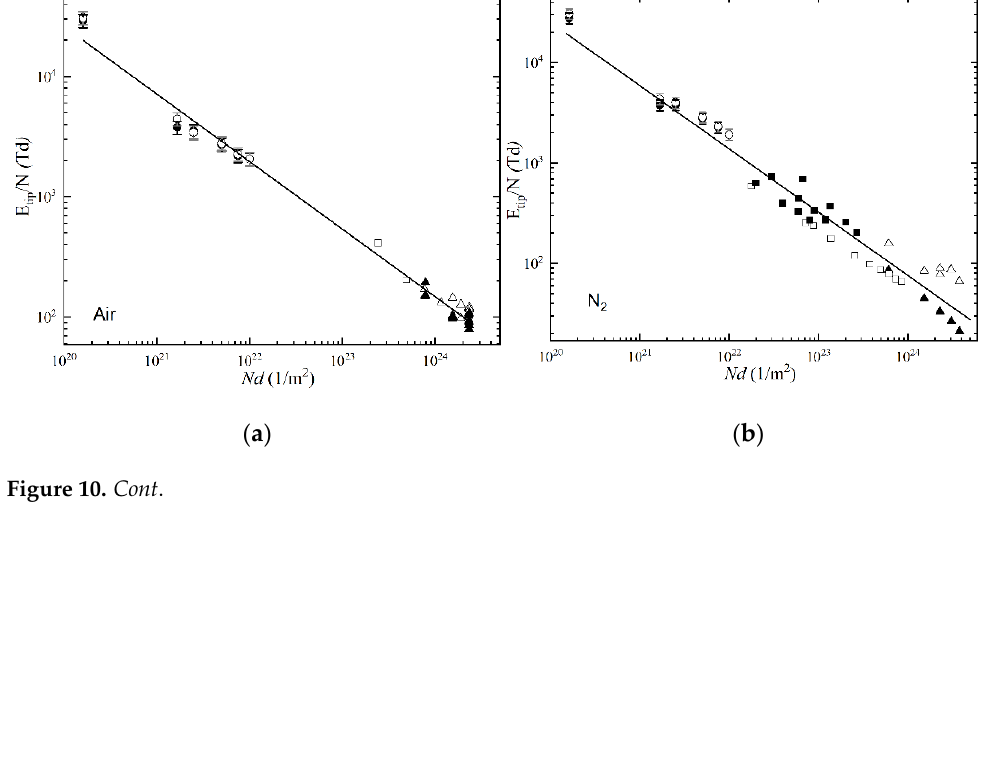
Figure 9. Field-time breakdown characteristic for different gases. Kinetic model, Equation (5), Nt f as a function of E / N : air, dotted line; N 2, solid dark line; CO 2 , solid gray line; SF 6 , dashed line. Experimental results obtained in the present work, Nt br as a function of E tip / N : air, (cid:3) —negative polarity, (cid:4) —positive polarity; N 2 , —negative polarity, • —positive polarity; CO 2 , (cid:52) —negative polarity; (cid:78) —positive polarity.